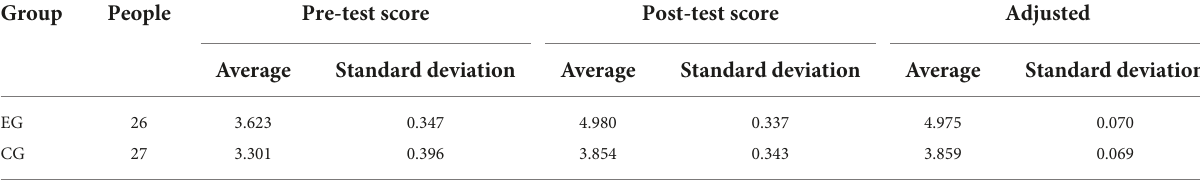
TABLE 7 The ANCOVA analysis of pre-test and post-test results of learning attitude.